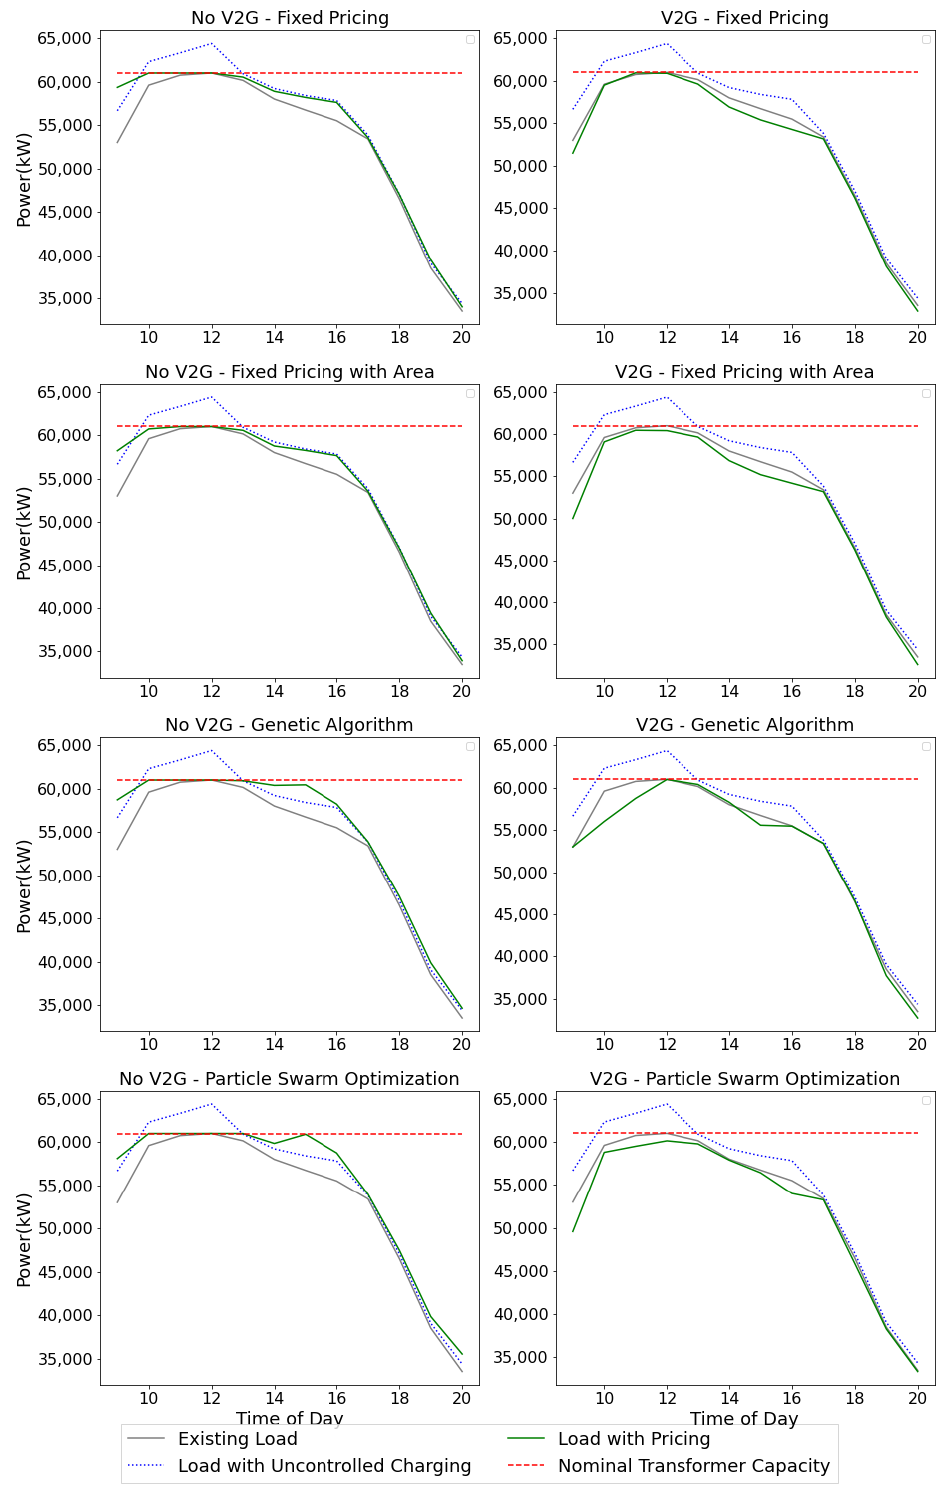
Figure 11. Charging allocation analysis for V2G availability and control algorithm (Canary Wharf area and 0% overload capacity). The red dotted line represents the nominal capacity of the distribution transformer; the grey line, the baseline load demand; the blue dotted line, the uncoordinated charging scenario; and the green line, the charging allocation with the respective algorithm.